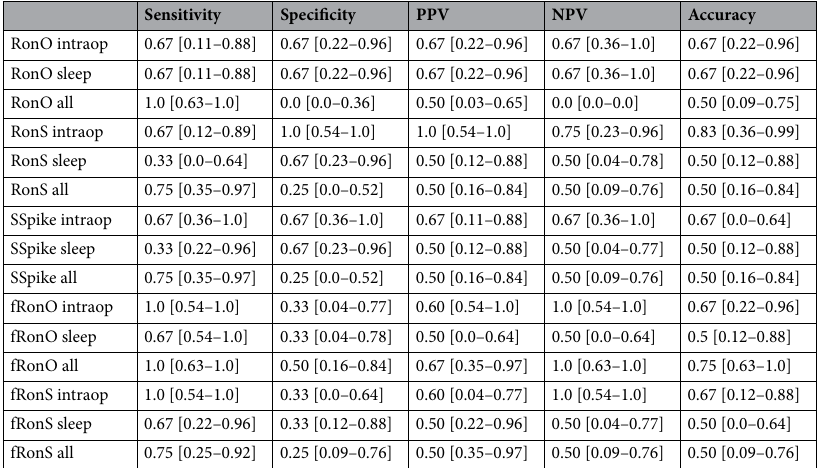
Table 2. Sensitivity, specificity, positive predictive value (PPV), negative predictive value (NPV, and accuracy of remaining HFO and sharp-spike (SSpike) positive regions (see “Methods” section) for predicting surgical failure (Engel Class ≥ 2) in the intraoperative and electrode matched non-REM sleep recordings (n = 6), and the sleep recordings from all contacts (all, n = 8). Brackets indicate 95% confidence intervals.